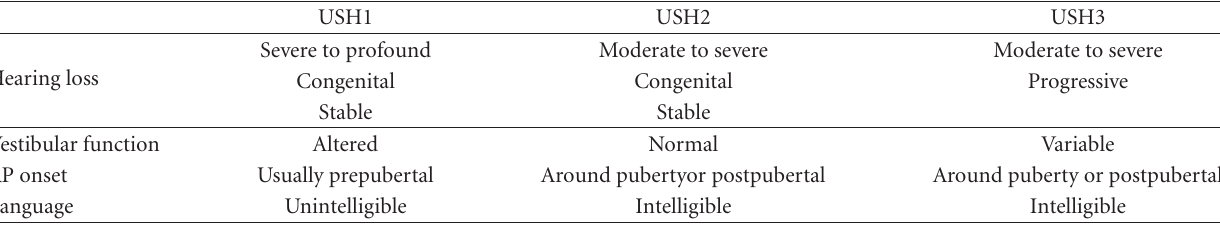
Table 1: Clinical features of Usher syndrome types.